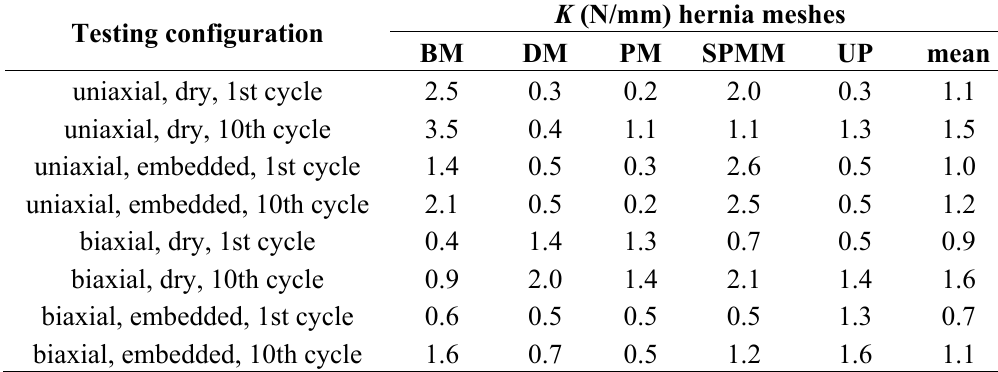
Table 3. Numerical values of stiffness for all hernia meshes and all tested